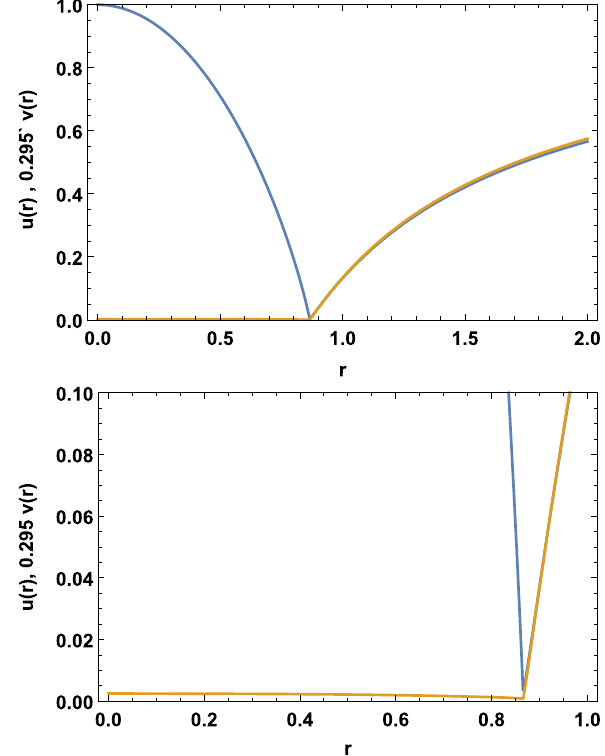
Fig. 1 Radial dependence of u ( r ) and v( r ) which define the metric. The top figure shows u ( r ) as the curve tending to unity at the origin of coordinates and v( r ) as the one approaching a much smaller value at the origin. The bottom figure shows the same curves in detail at the boundary. Note that the potential v( r ) exhibits a maximum at the origin. Therefore, in this case the gravitational potential decreases away form the center. This is a behaviour similar to the classical gravastars solutions [6–8]